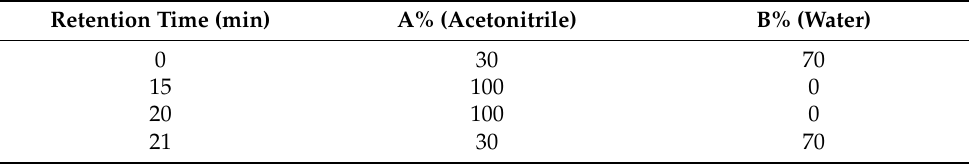
Table 1. Gradient elution system for oligomer